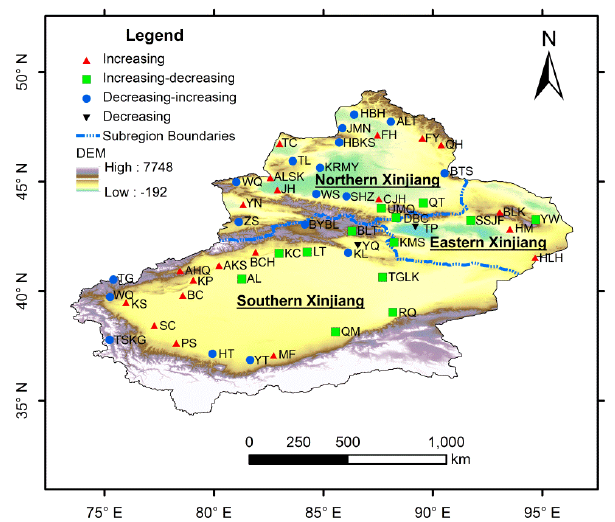
Figure 9. Spatial distribution of the types of variation trends in precipitation in Xinjiang.